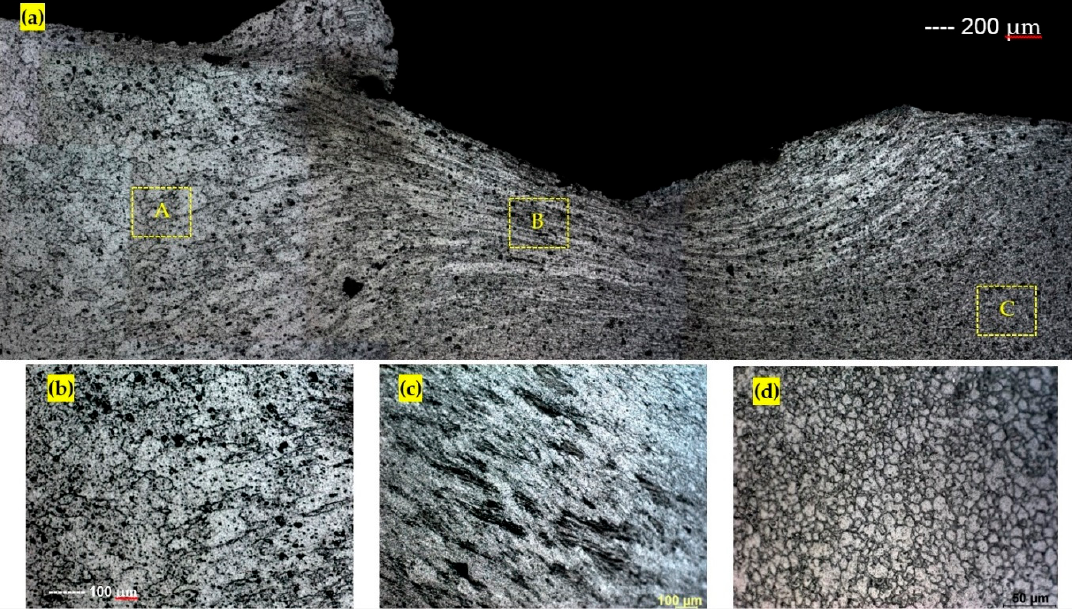
Figure 10. Grain and flow details of the sub-shoulder region of the weld crown (Reagent B). ( a ) macrograph of the sub-shoulder region; different microscopic features are enlarged as Regions A, B, C in Figures 10 b–d, respectively; ( b ) Regions A; coarse grain structure, ( c ) Regions B; elongated grains, ( d ) Regions C; ultrafine grained microstructure.